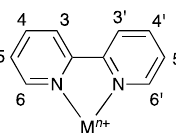
][CdCl ] (refcode 3 4